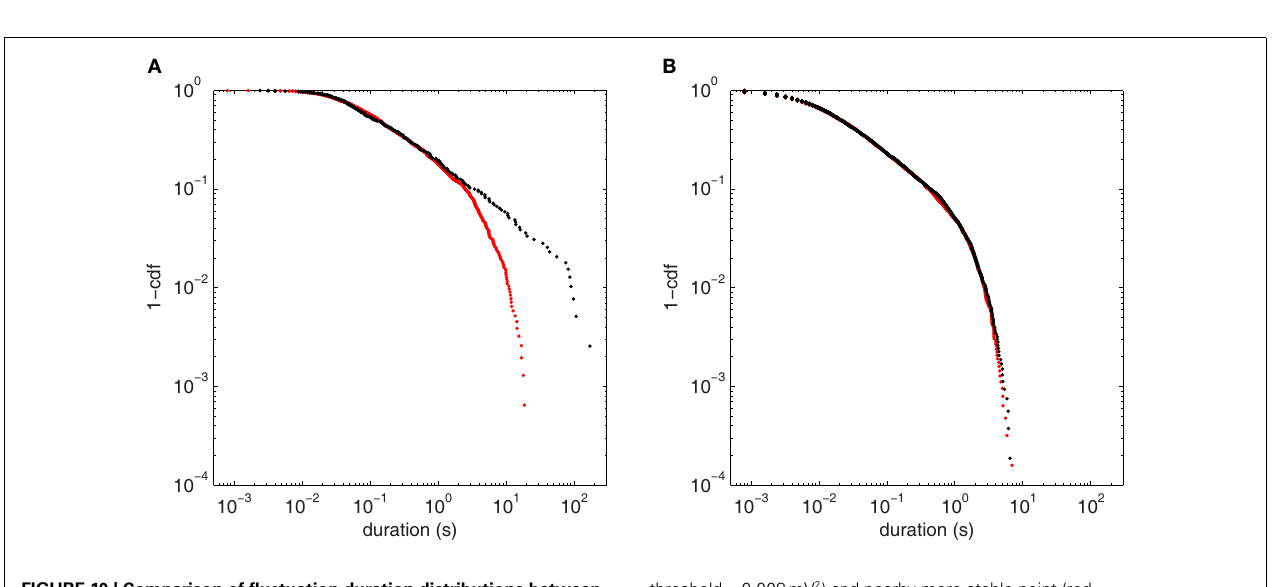
FIGURE 10 | Comparison of fluctuation duration distributions between points approaching ( p = 65.3s − 1 ) and at the bifurcation point ( p = 80.3s − 1 ) for the two noise input directions. (A) Point H3u (black,